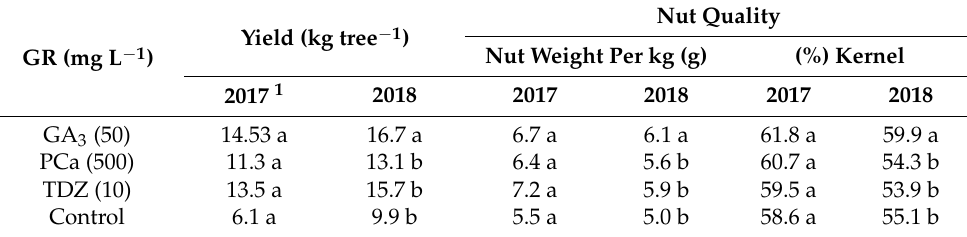
Table 3. Application of GR to in cv. “Wichita” pecan trees and the inter-annual effect on nut yield and